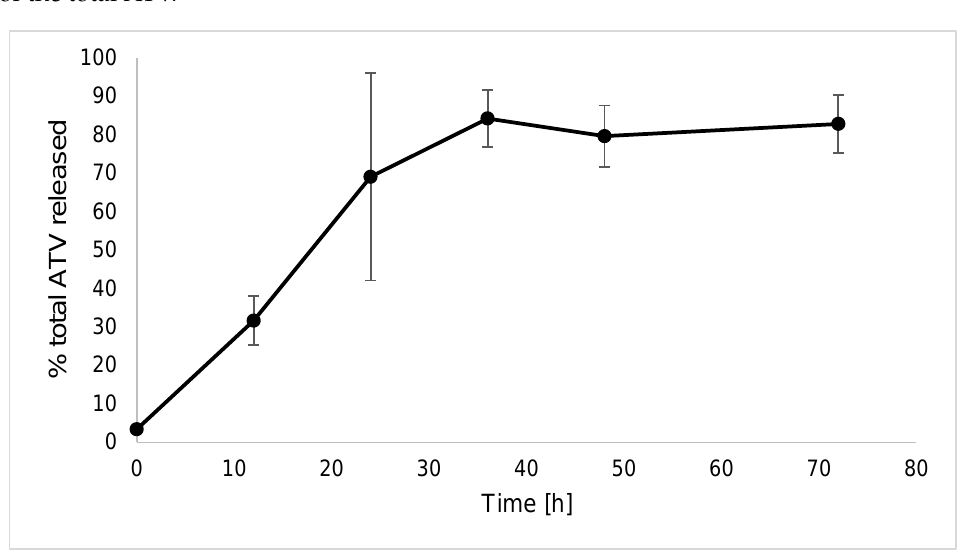
Figure 9. Cumulative release of atorvastatin from the HA-Dop NaOH-CL gel. n = 3, error bars = SD.